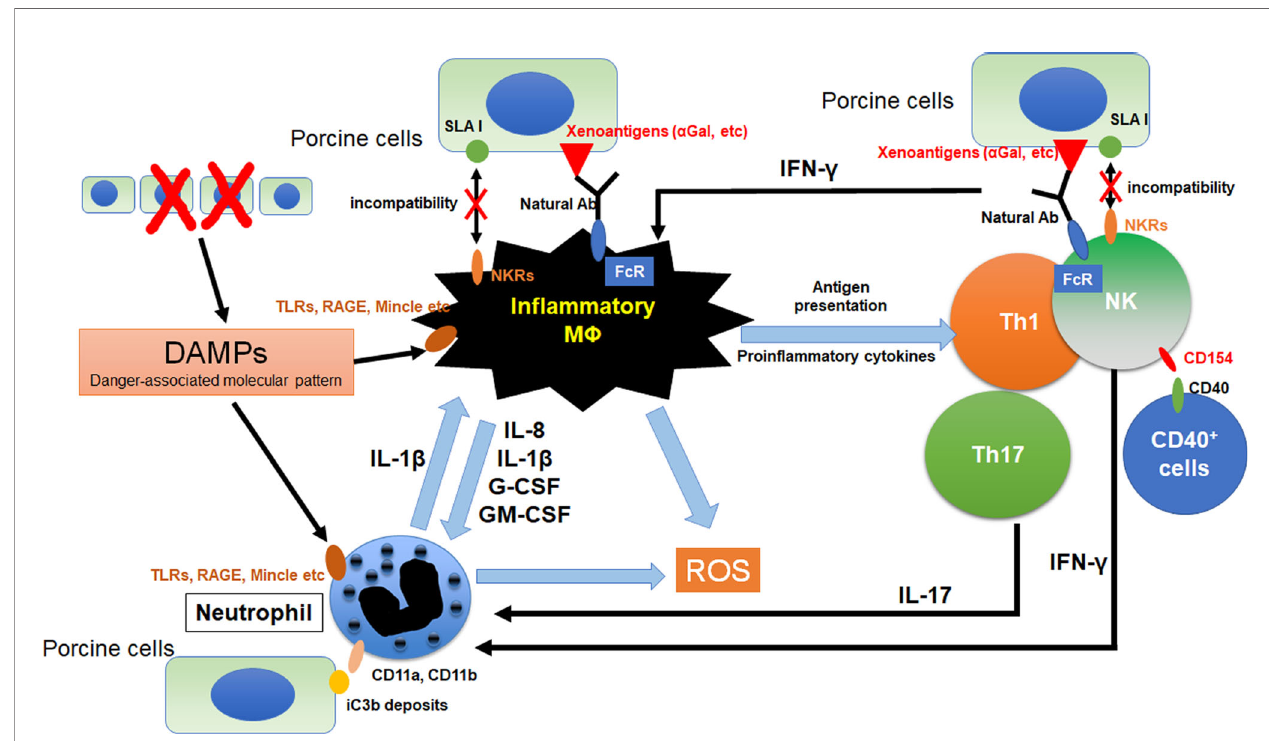
FIGURE 1 | Crosstalk between macrophages and other innate immune cells in xenograft. The immunocomplex of porcine cells and natural antibodies against porcine antigens binds to Fc receptors (FcRs) on macrophages and NK cell. Activated NK cell and macrophage induce antibody-dependent cellular cytotoxicity (ADCC) against porcine cells. Furthermore, incompatibility between SLA1 and NK receptors (NKRs) causes macrophage and NK cell activation because of lack of inhibitory signals. Macrophages were activated by the binding of DAMPs from dead cells to toll-like receptors (TLRs), receptor for advanced glycation end-products (RAGE) and macrophage- inducible C-type lectin (Mincle). Activation signals were induced and various pro-in fl ammatory cytokines are released from macrophages. These cytokines activate neutrophils and promote NETosis. Especially, IL-8 contributes to the neutrophil recruitment and IL-1 b enhances NETosis formation in neutrophils. In addition, NETs from neutrophils also activate macrophages as DAMPs. Macrophages can activate NK cells and IFN- g from activated NK cells was known to activates both macrophage and neutrophil. CD11a and CD11b on neutrophils bind to iC3b deposits on porcine cells, suggesting that neutrophils can recognize porcine target cells via binding of CD11a,b and iC3b. CD154 on NK cells enhances NK cytotoxicity to CD40 positive target